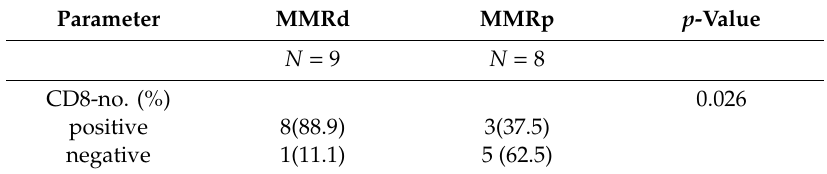
Table 3. Relationship between status of MMR and CD8 expression. (unde ffi rentiated